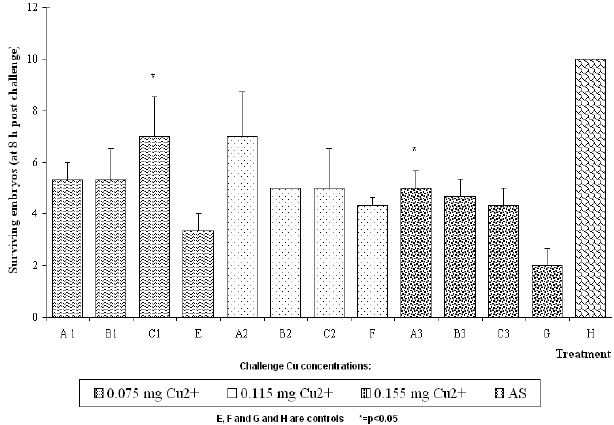
Figure 1: Survival of Bufo arenarum embryos treated with low copper concentrations and challenged to different lethal concentrations of this